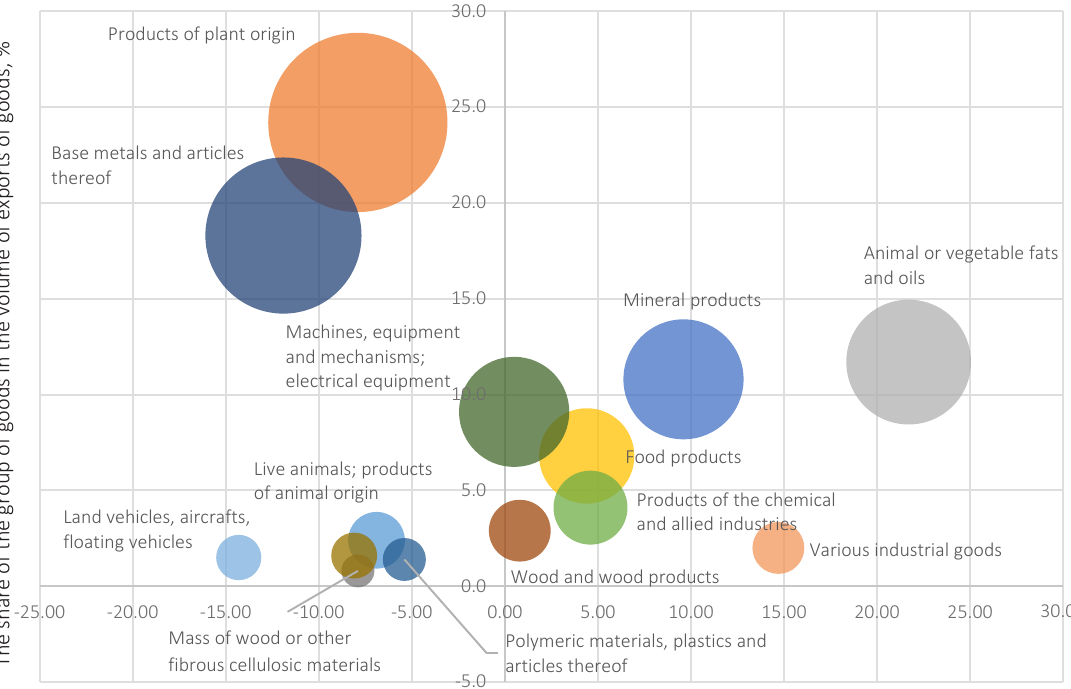
Figure 3. Dynamics of main merchandise export groups in Ukraine in